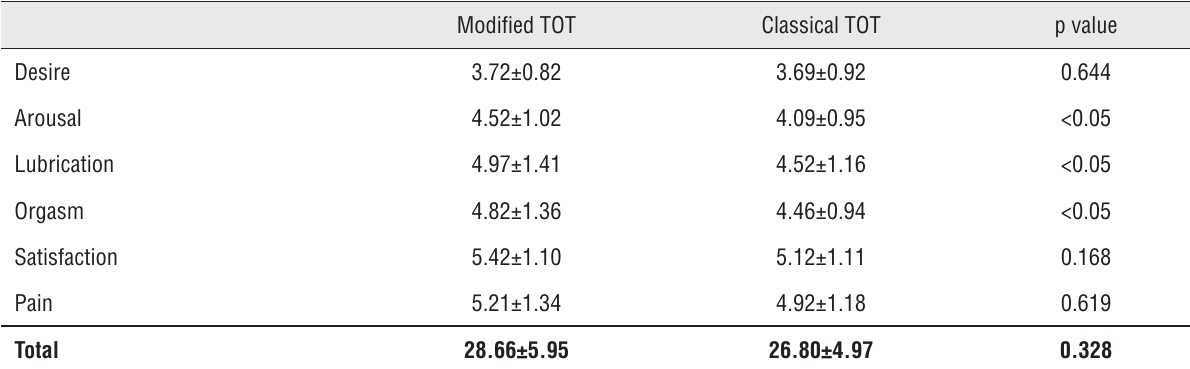
Table 4 - Comparison of postoperative FSFI scores for modified and classical